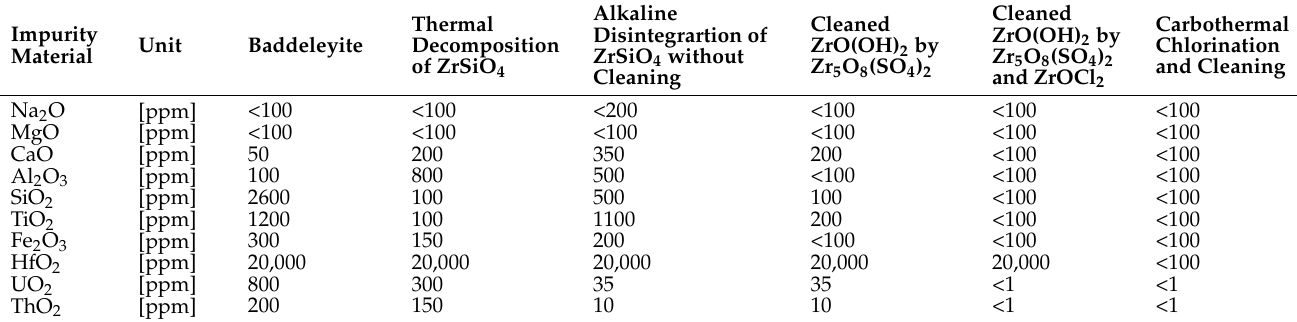
Figure 8. Powder morphology of standard grade zirconia powder ( left ) and the nano-scaled powder ( right ) made by synthesis without calcination. Table 1. Overview table of zirconia powders derived by different processing